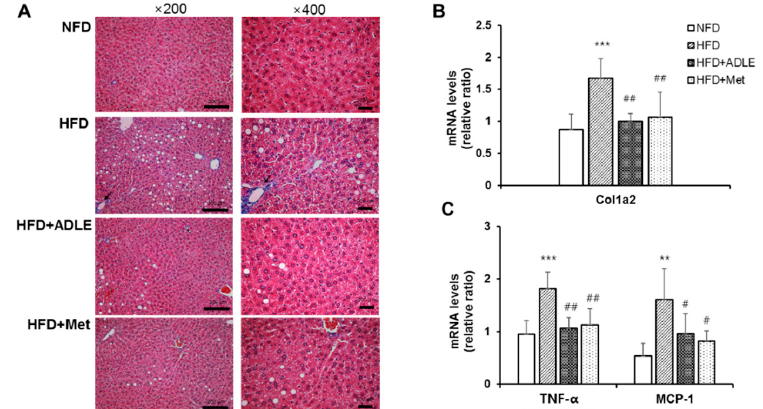
Figure 4. ADLE reduced hepatic fibrosis and inflammation in the liver of HFD-induced diabetic mice. ( A ) Liver sections were stained with Masson’s trichrome (scale bar = 200 µ m) and ( B , C ) the mRNA expression of Col1a2, TNF- α , and MCP-1 in the liver was determined by RT-PCR. The results are expressed as means ± SD ( n = 6–8). ** p < 0.01, *** p < 0.001 vs. NFD group. # p < 0.05 and ## p < 0.01 vs. HFD group. NFD, normal-fat diet; HFD, high-fat diet; HFD + ADLE, high-fat diet + ADLE; HFD + Met, high-fat diet +